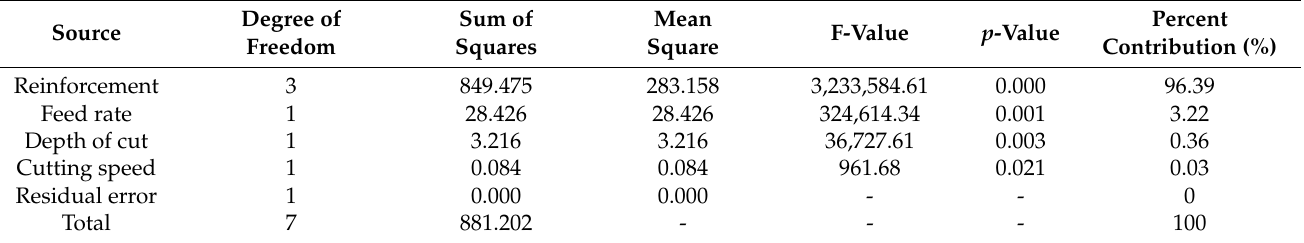
Table 5. Analysis of variance for S/N ratios of flank